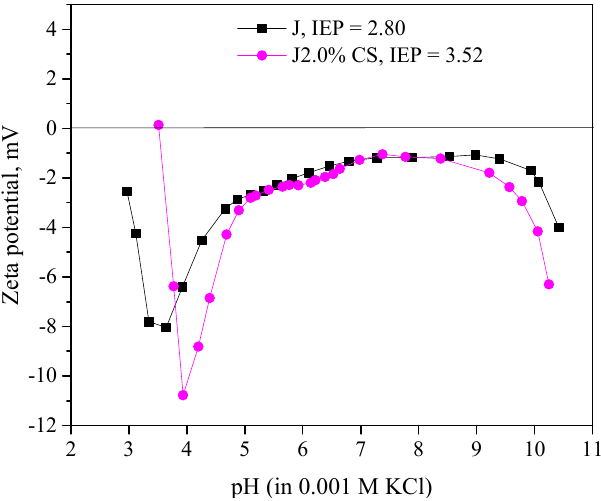
Figure 4. Zeta potential and isoelectric points (IEP) of J and J2.0% CS.